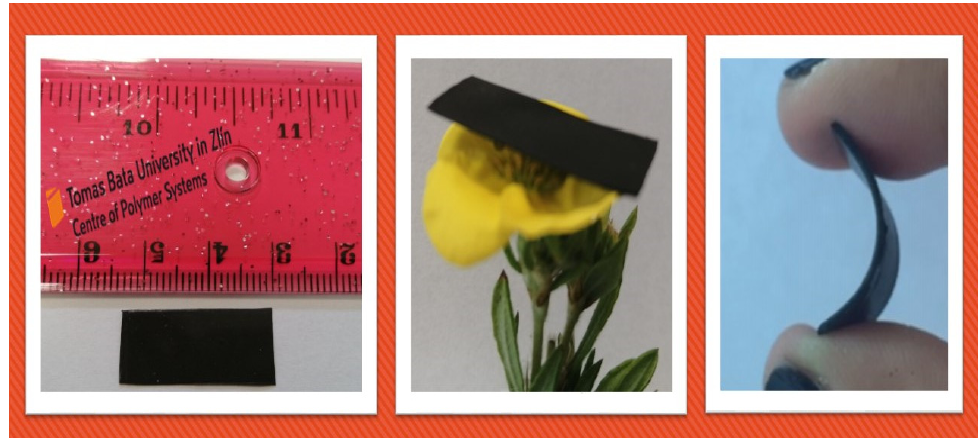
Figure 3. Digital photograph of PP nanocomposite embedded with MnFe 2 O 4 spinel ferrite nanoparticles and reduced graphene oxide (RGO) as nanofillers.